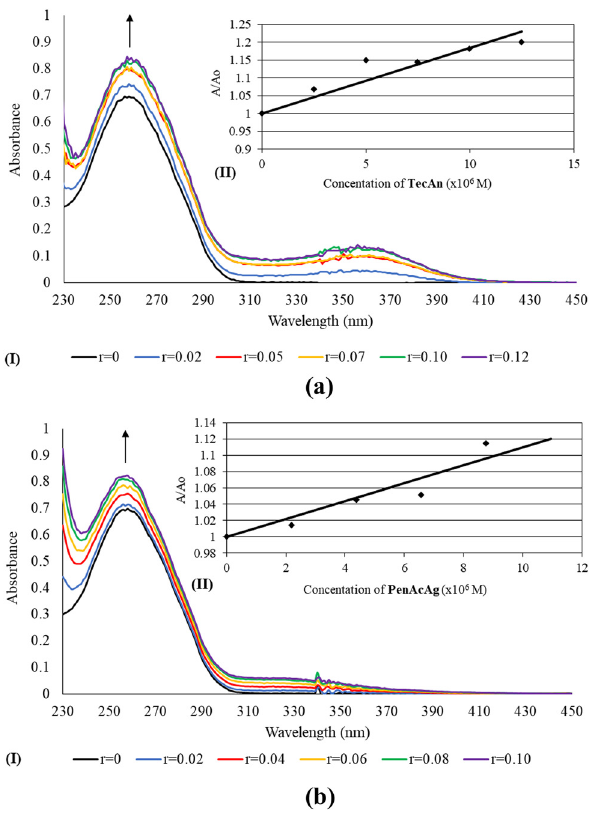
Figure 8: ( I ) UV - Vis spectra of CT - DNA in bu ff er solution in the absence and presence of TecAn ( a ) and PenAcAg ( b ) at various r values ( 0, 0.02, 0.05, 0.07, 0.10, and 0.12; r = [ complex ] / [ DNA ] , [ DNA ] = 10 − 4 M ) and ( II ) plot of A/Ao vs [ complex ] at 258